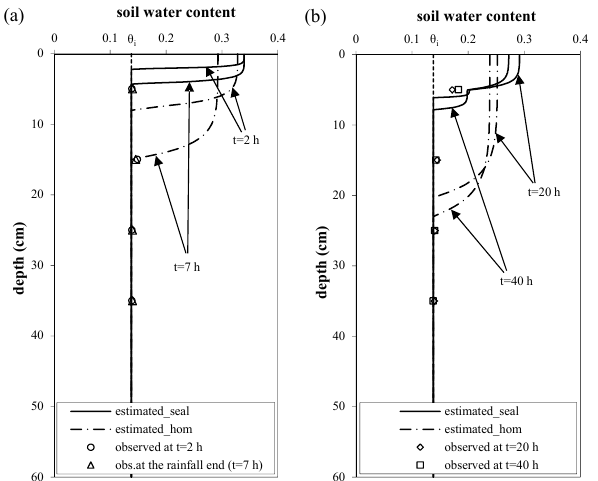
Fig. 6. Water content profiles simulated by the adopted models for homogeneous soil and sealed soil and specific values observed at different depths during (a) the infiltration stage, (b) the redistribution stage. Event 4 of Fig. 2 (see also Table 2). Saturated hydraulic conductivity of the parent soil 2mmh − 1 and seal layer 0.03mmh − 1 .